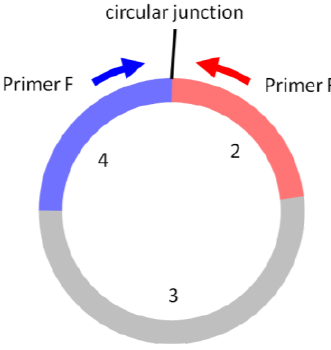
Figure 6. In circRNA-qPCR, Primer F and Primer R are situated on the two sides of the circular junction, producing the amplicon that spans the circular junction. The exon numbers are for illustration only.